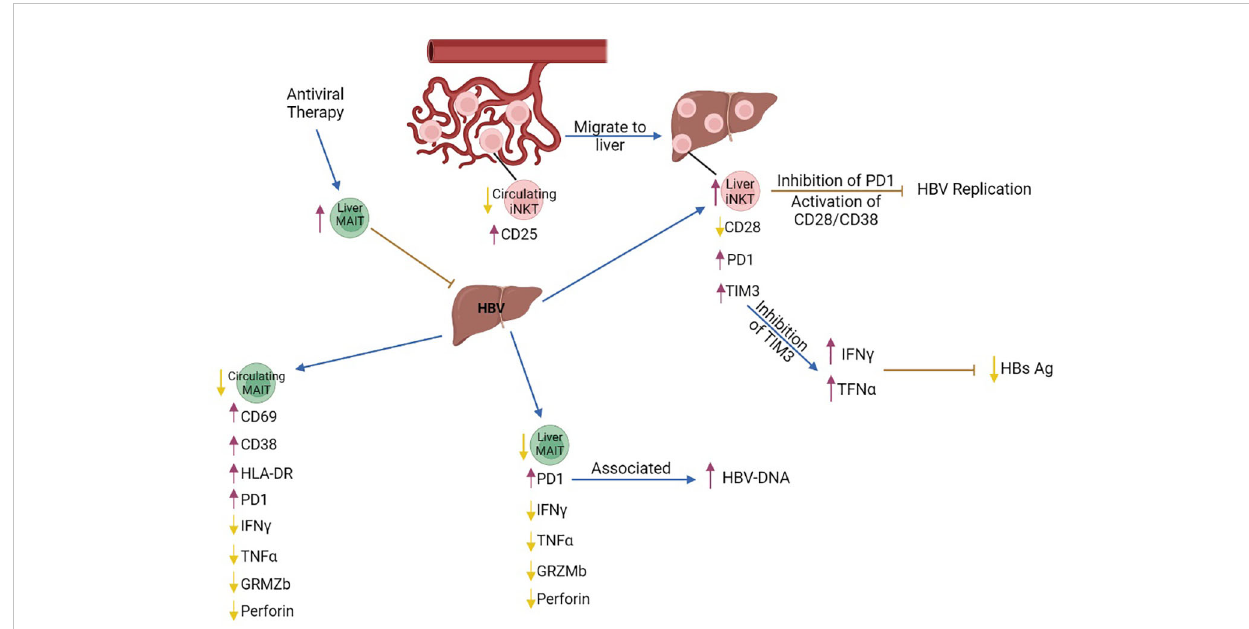
FIGURE 1 The role of MAIT and iNKT cells in chronic HBV infection. Intrahepatic iNKT cells highly express the exhaustion markers PD1 and TIM3 while expression of the activated marker CD28 is decreased. Inhibition of PD1 and activation of the CD28/CD38 signaling pathway in liver iNKT cells leads to inhibition of HBV replication. Inhibition of TIM3 expression in liver iNKT cells leads to increased production of IFN g , which increases production of type I interferons, IFN a and IFN b , leading to reduction of HBs Ag levels. Although the number of circulating MAIT cells is decreased, the remaining cells express the activation markers CD69 and HLA-DR, and the chronic activation marker CD38, while production of IFN g , TNF a and Granzyme B is decreased. The number of liver MAIT cells is lower in chronic HBV, and they are characterized by increased expression of PD1. PD1 + MAIT cells are associated with an increase in HBV-DNA levels. Antiviral therapy increased the frequency of MAIT cells in the liver and contributed to viral clearance. purple arrows, increase; yellow arrows, decrease; brown arrows, inhibition; blue arrows,